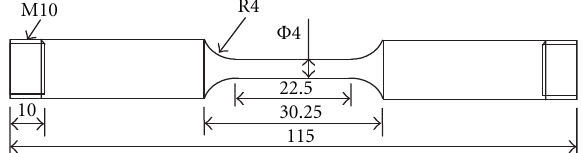
Figure 2: The configuration of the tensile specimen used.